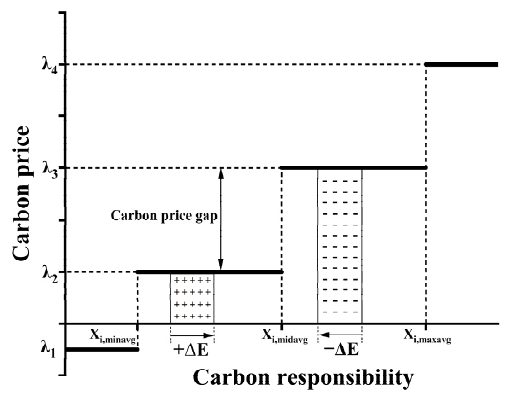
Figure 14. The influence mechanism of the ladder-type carbon price on the DR. To demonstrate the promoting effect of the carbon price gap on the DR, two different carbon pricing cases were compared in Scenario 2.